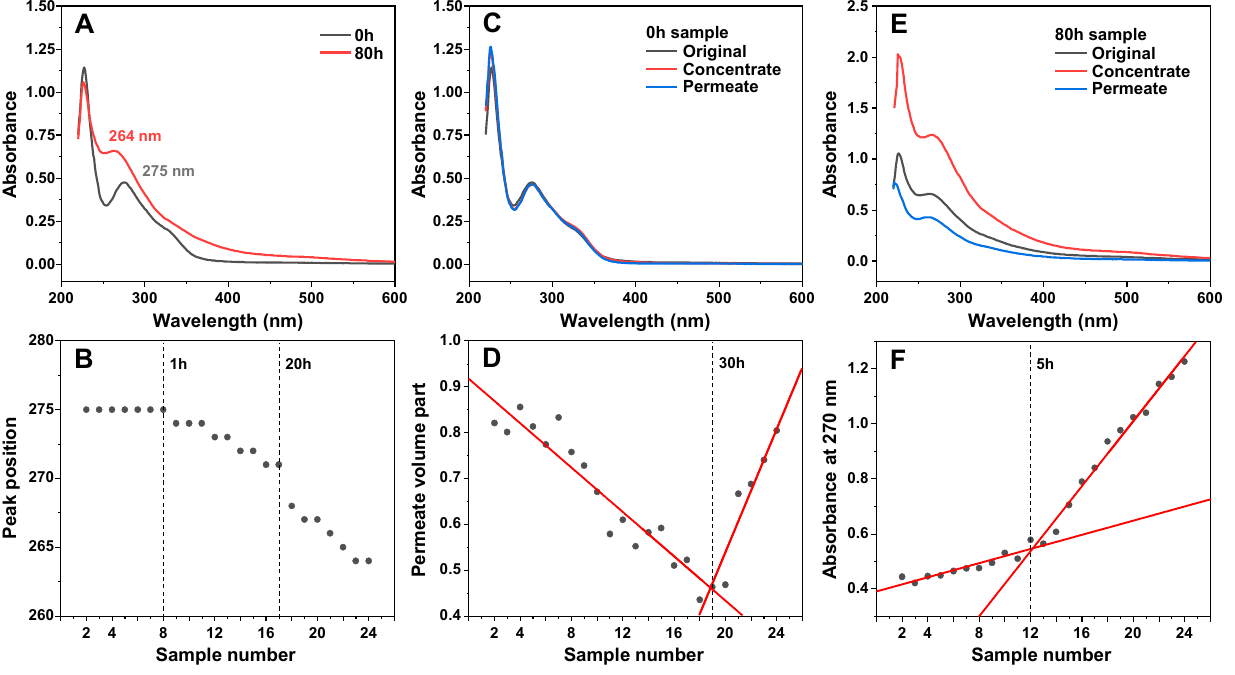
Figure 1. EGCG sample absorbance and membrane permeability changes during incubation. Ab- sorbance spectra of EGCG before and after 80 h of incubation at 60 °C ( A ) and a shift in its charac- teristic peak position during the incubation time frame ( B ). Non-incubated EGCG sample concen- trate and permeate absorbance spectra ( C ). Sample permeate volume part dependence on sample number ( D ). EGCG sample concentrate and permeate absorbance spectra after 80 h incubation ( E ). Concentrate absorbance at 270 nm by on sample number ( F ). Sample preparation and measurement procedures are described in the Materials and Methods section.